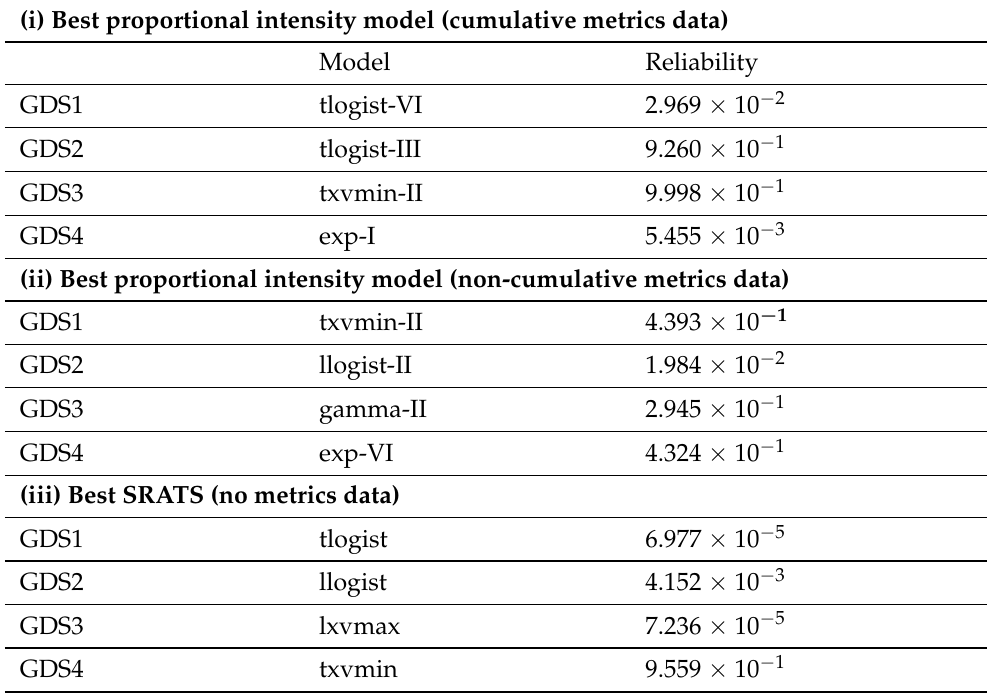
Table 7. Software reliability assessment with best SRM (minimum